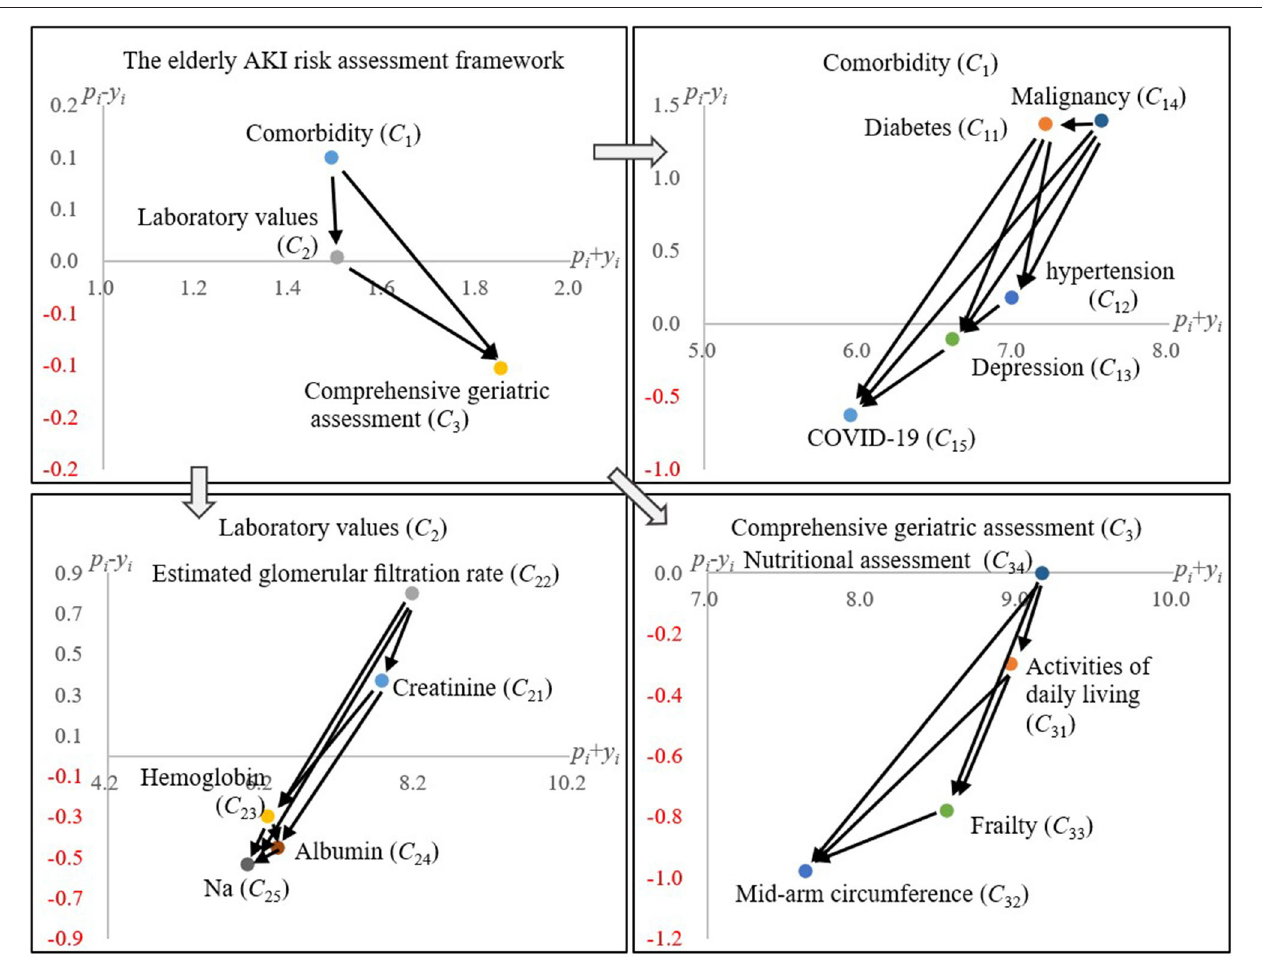
FIGURE 3 | The influential network-relation diagram with COVID-19 risk factor.